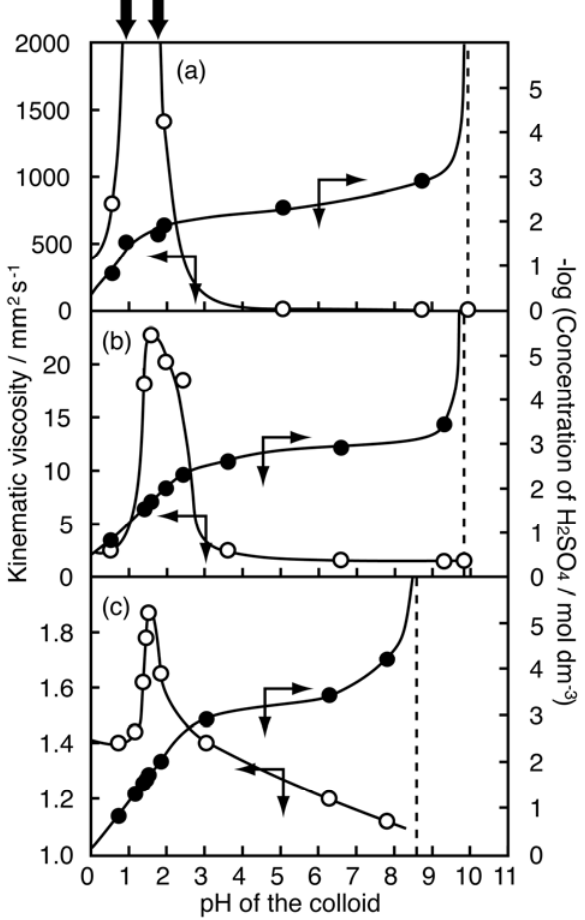
Figure 9. Variations in kinematic viscosity of the niobate nanosheet colloids with pH (open circles), and titration curves of the colloids (relationship between pH and concentration of H SO added) (filled circles) [158]. Concentration of the colloids are (a) 2 4 O ] 4– , respectively. For the colloid with 7.3 g L –1 of 7.3, (b) 2.4, and (c) 0.8 g L –1 of [Nb 6 17 [Nb O ] 4– , viscosity is too high to be measured at pHs indicated by the arrows on the top. 6 17 The dashed lines show pHs where [SO 42– ] = 0. Reprinted with permission from Ref. [158]. Copyright 2003 American Chemical